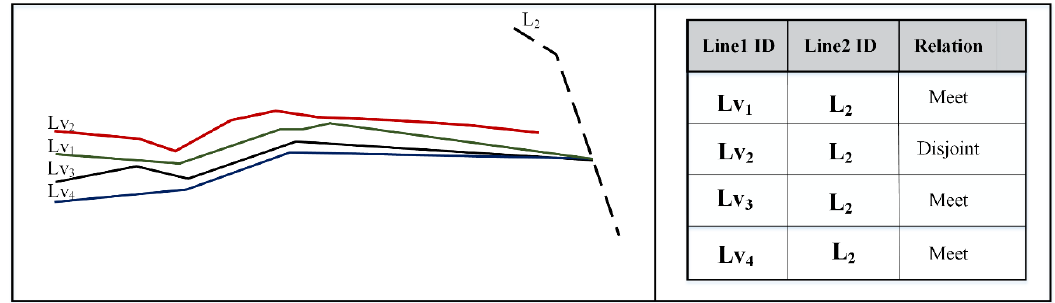
Figure 16. An example of the topology relationships between two linear objects.